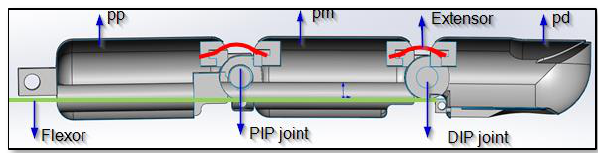
Figure 1. 3D model of finger phalanges and joints.